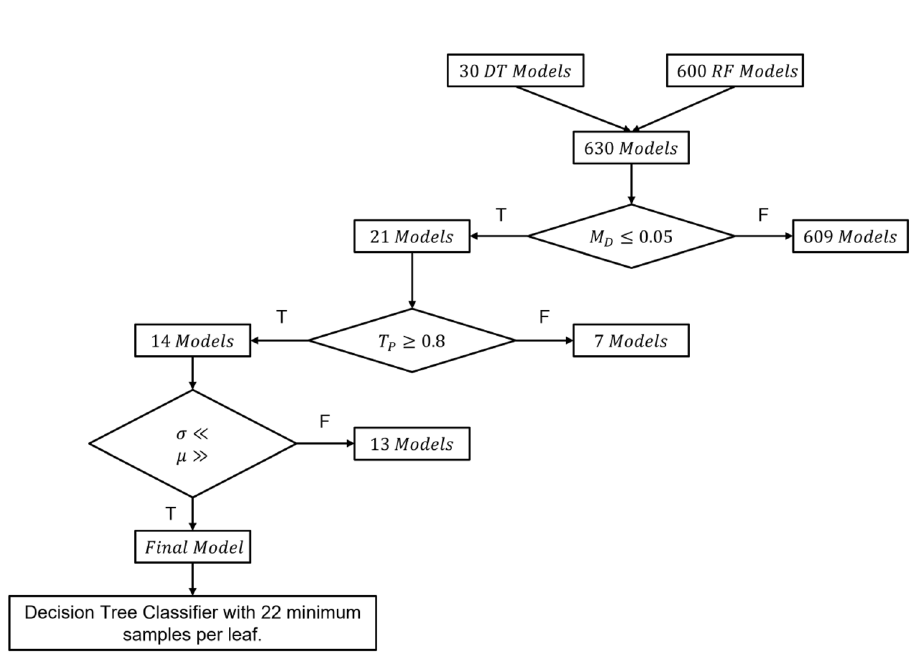
Figure 6. Hyperparameters selection